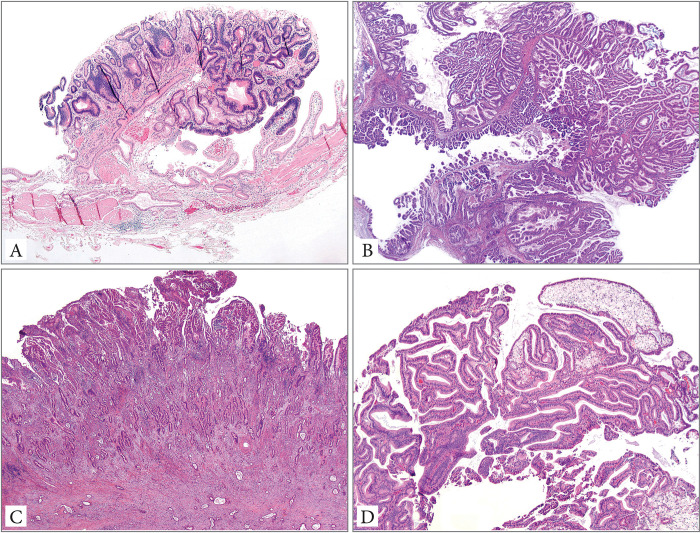
Neoplastic polyps: Incipient intracholecystic neoplasm (<1 cm by definition) (A), intracholecystic neoplasm (B), polypoid invasive adenocarcinoma (C) and non-neoplastic polyp (in this case, a cholesterol polyp) with low grade dysplasia (Hematoxylin&eosin, 10x magnification) (D).